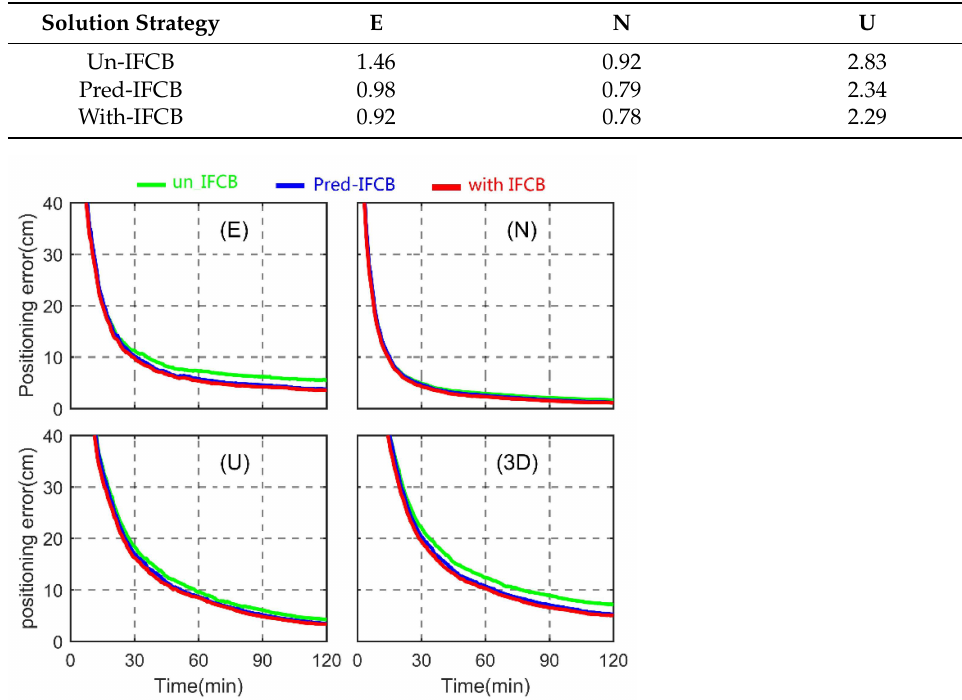
Table 3. Mean coordinate residuals of triple-frequency un-combined PPP of three cases (cm).